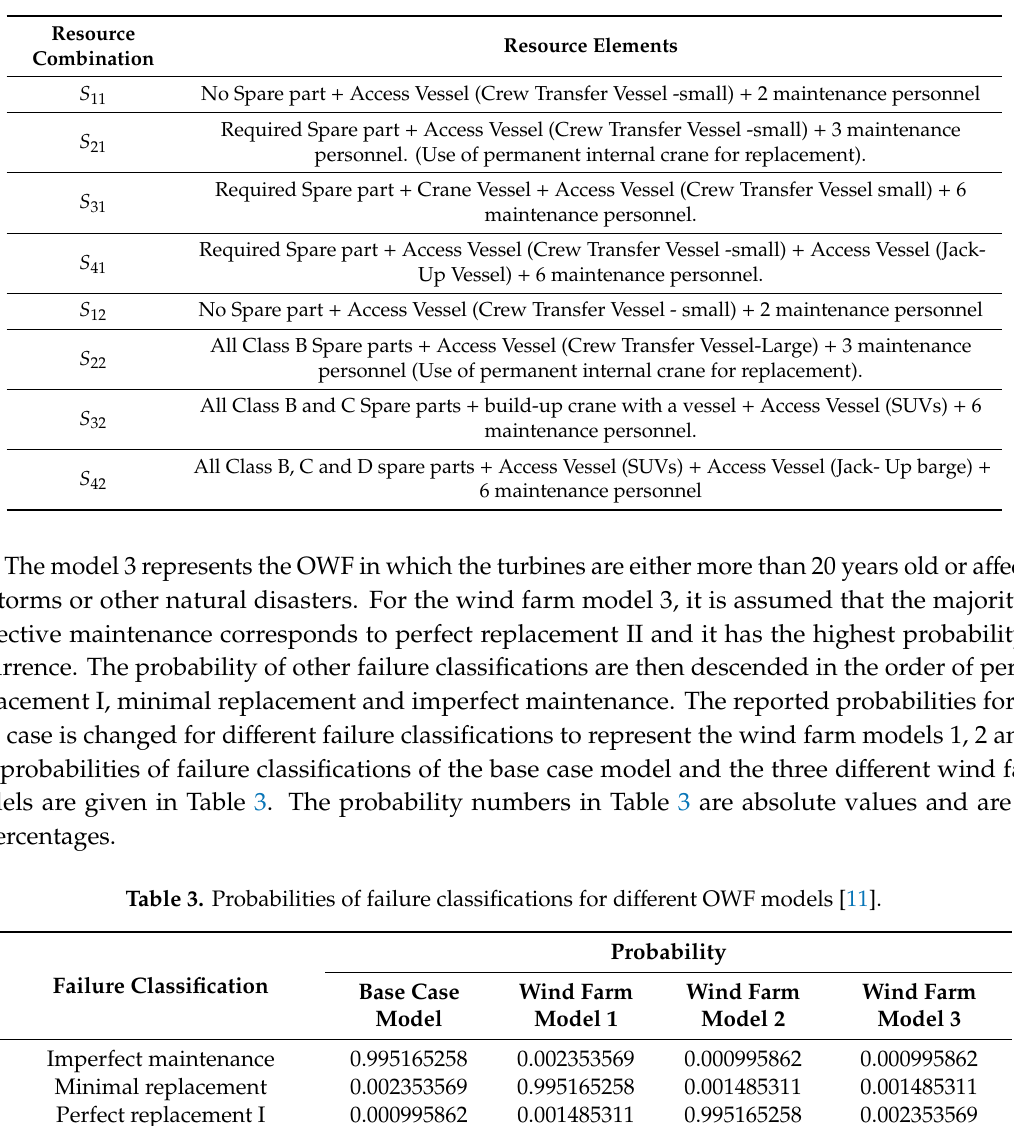
Table 2. Decision Choices [11,15].